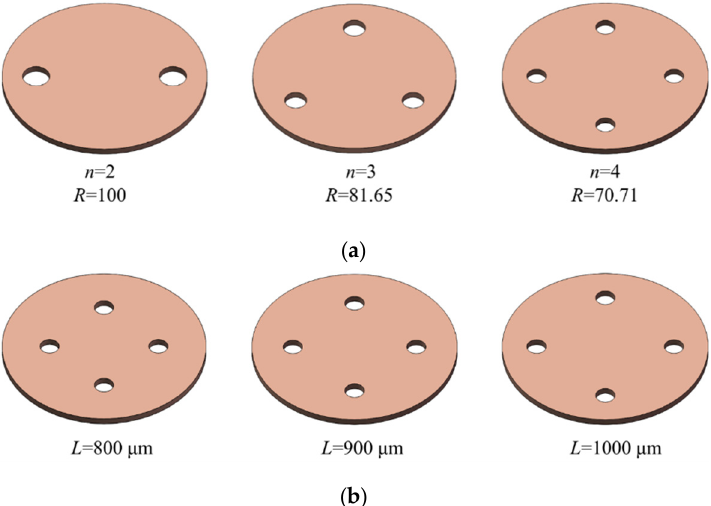
Figure 2. The microholes design on the PDMS membrane. ( a ) Number of microholes ( L = 1000 µ m), ( b ) different pitches of microholes ( n = 4).